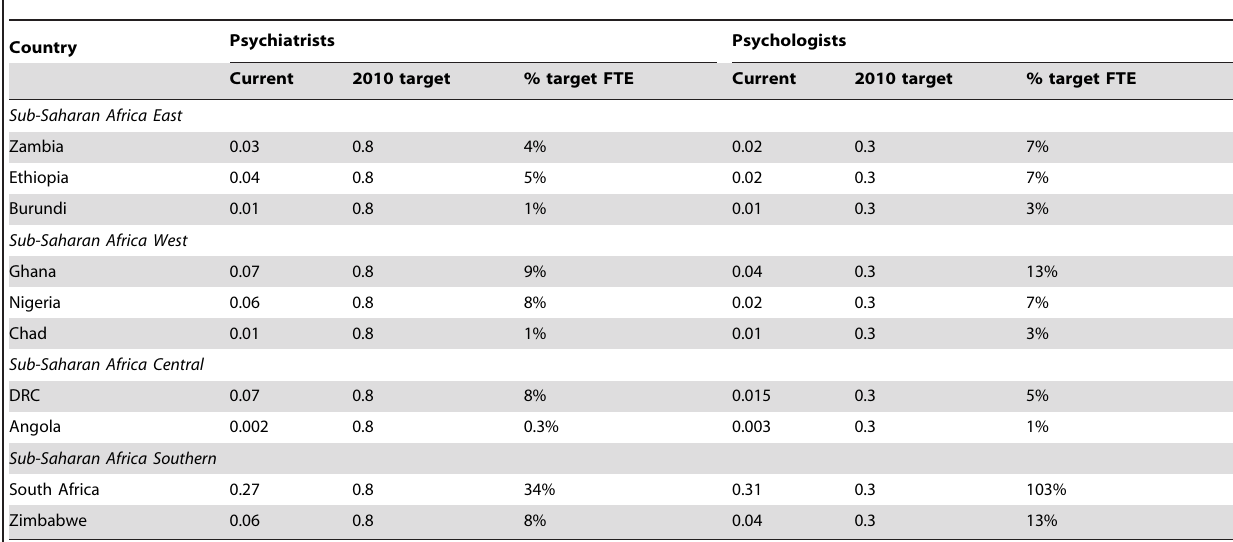
Table 2. Current and target 2010 FTE psychiatrists and psychologists per 100,000 population for selected countries in Sub- Saharan